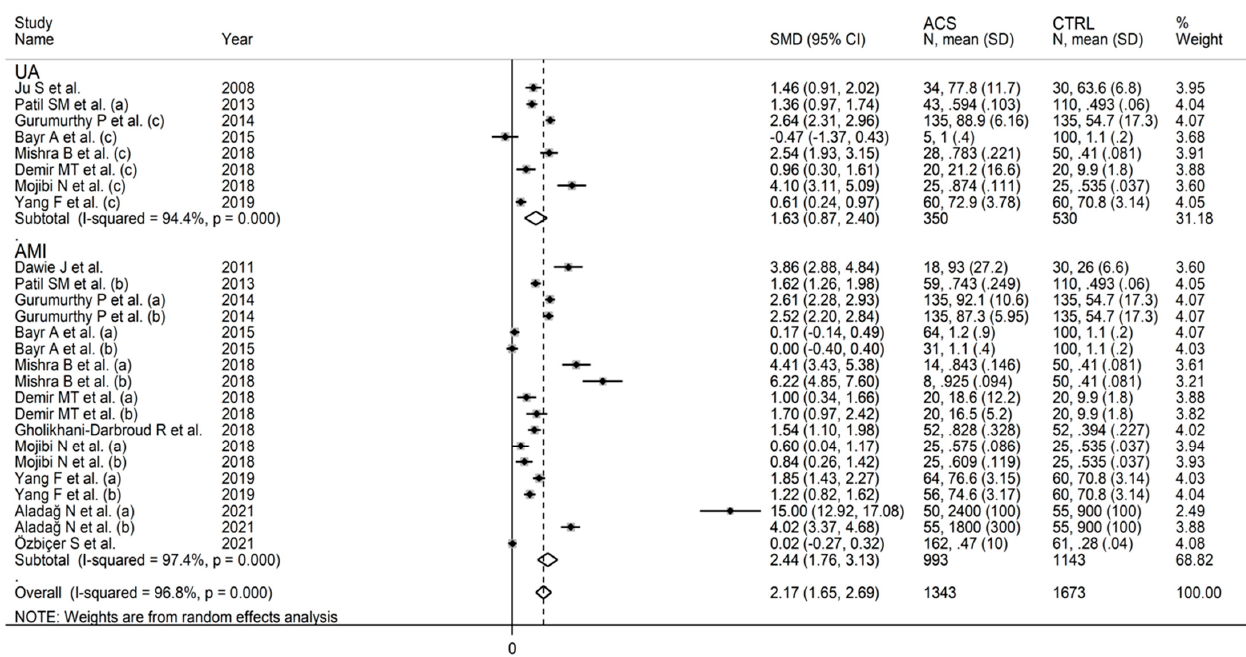
Figure 6. Forest plot of studies examining ischaemia-modified albumin in patients with acute myocardial infarction or unstable angina vs. controls.